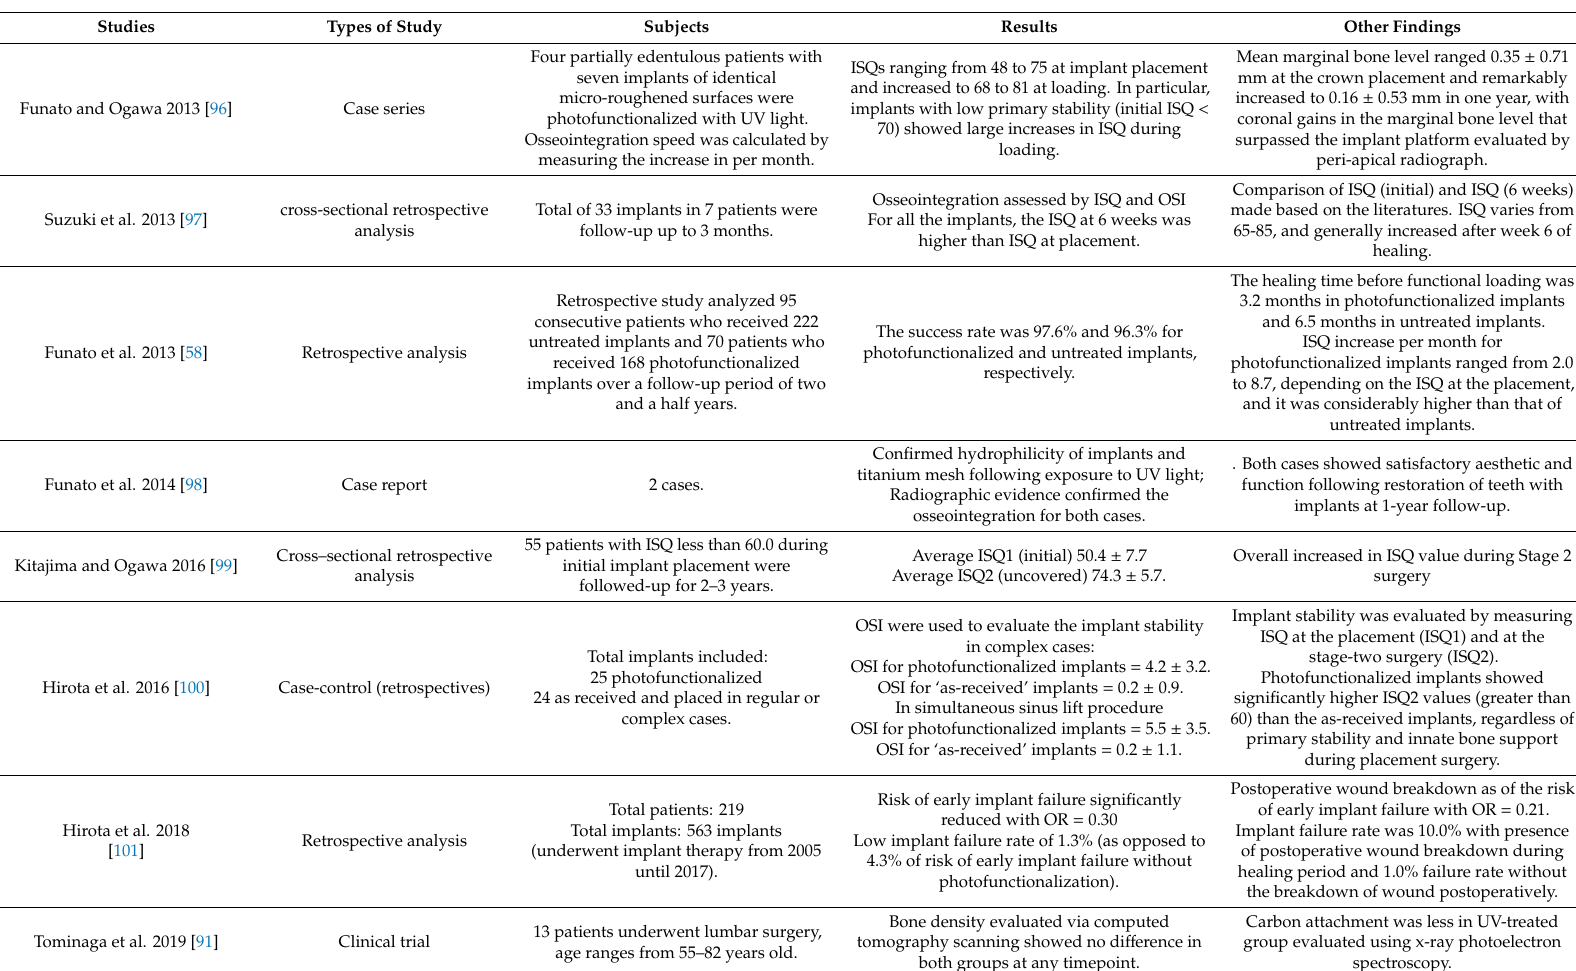
Table 5. E ff ect of UV photofunctionalization in